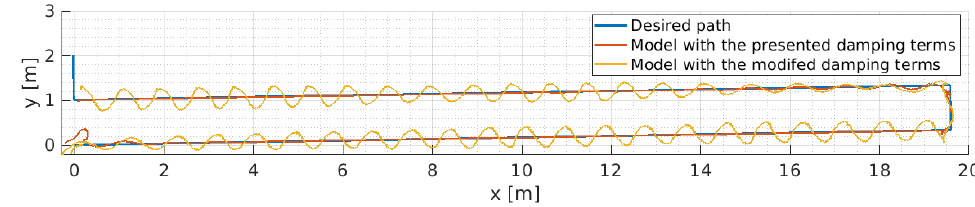
Figure 12. Simulation results for path following employing the modified controller with hydrody- namic damping terms multiplied by a factor of 0.5.